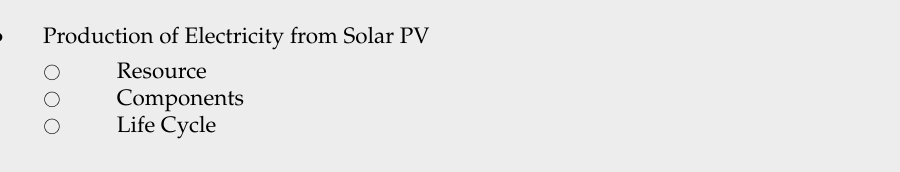
Table 3. Hierarchy for the Production of Electricity from Solar